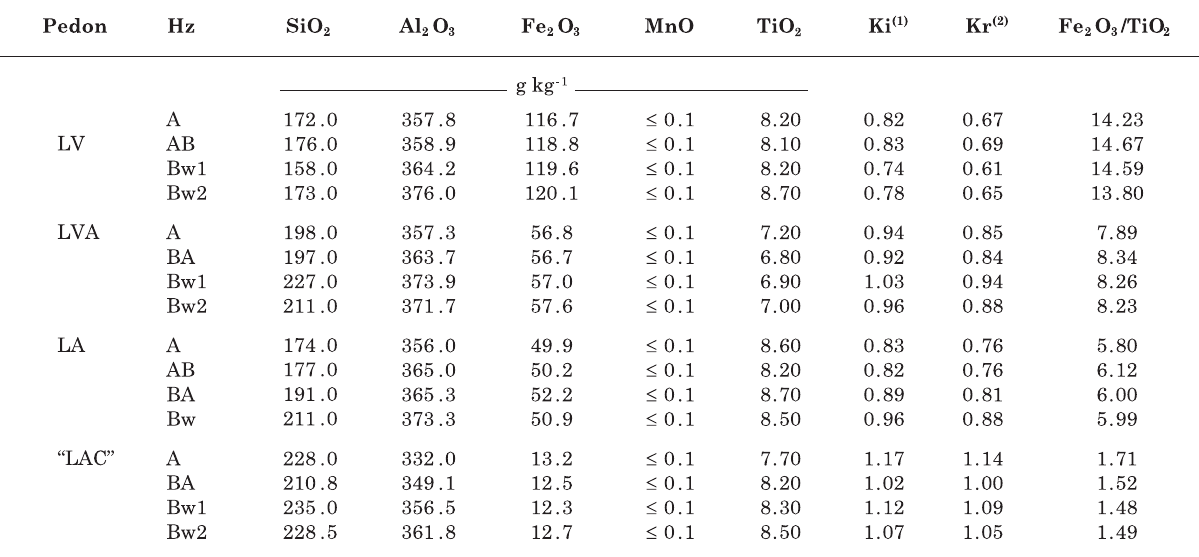
Table 5. Total oxide contents determined by sulfuric attack, Ki and Kr indices and Fe toposequence